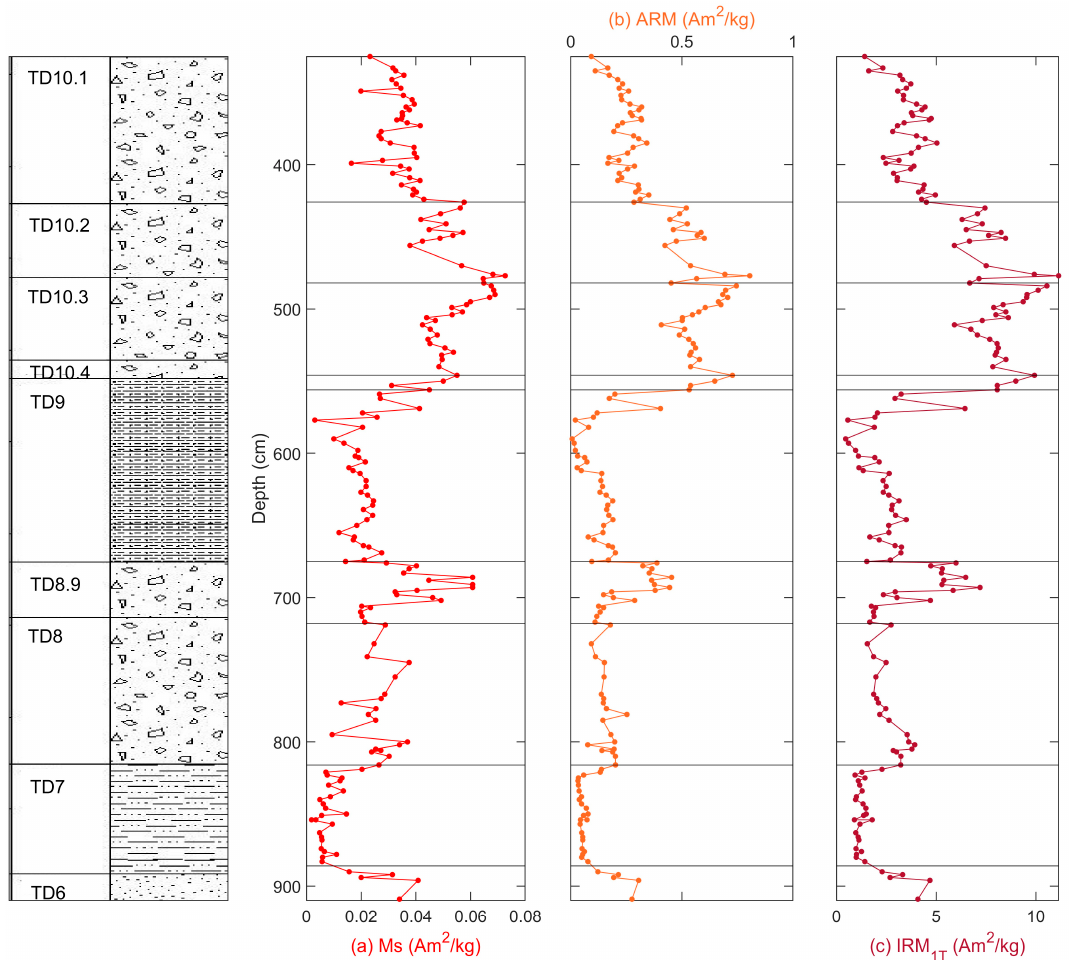
Figure 7. Remanent magnetization profiles: ( a ) saturation magnetization (M s )—taken from the hysteresis loops—( b ) anhysteretic remanent magnetization (ARM), ( c ) isothermal remanent